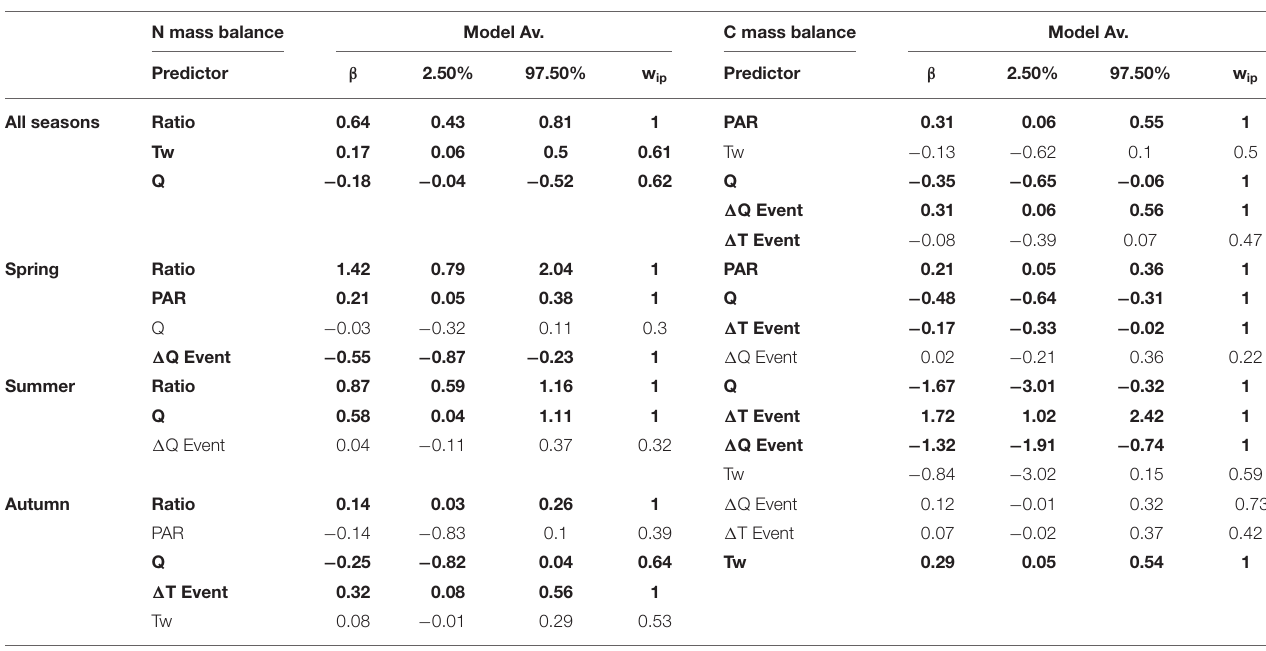
TABLE 4 | Results of the model selection process for daily mean mass balance data. N mass balance Model Av. C mass